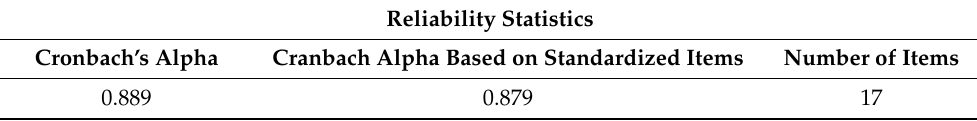
Table 2. Cranbach Alpha coefficient of the questionnaire results of potential risk events.